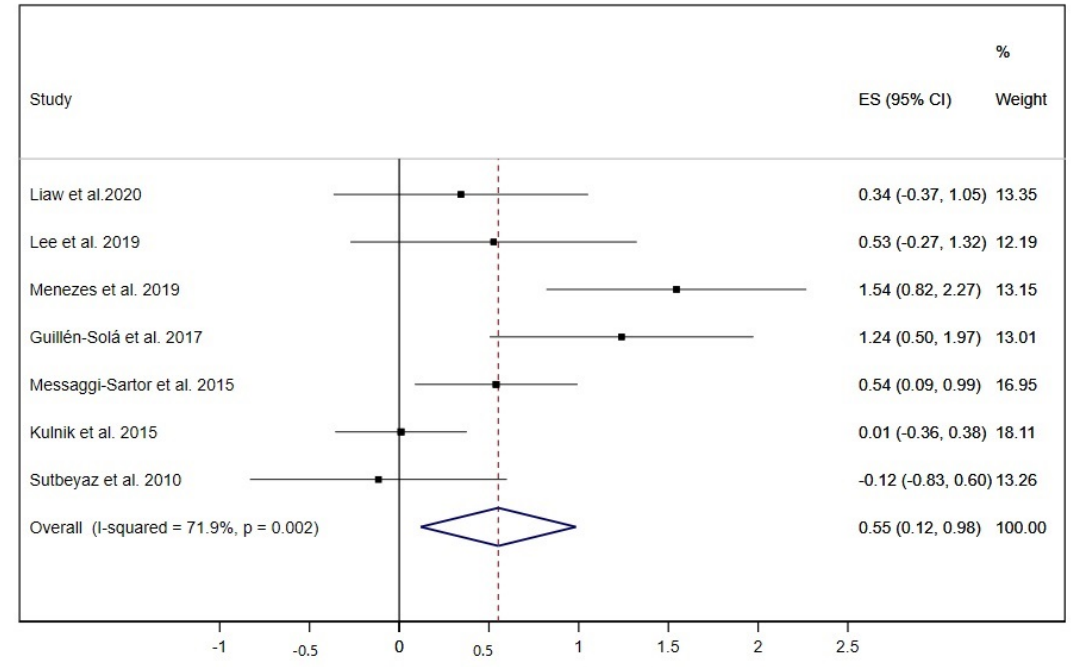
Figure 5. Forest plot showing the e ff ect size (ES) of respiratory muscle training (RMT) on maximal expiratory pressure (MEP) between intervention and control groups for each study. IMT, inspiratory muscle training; EMT, expiratory muscle